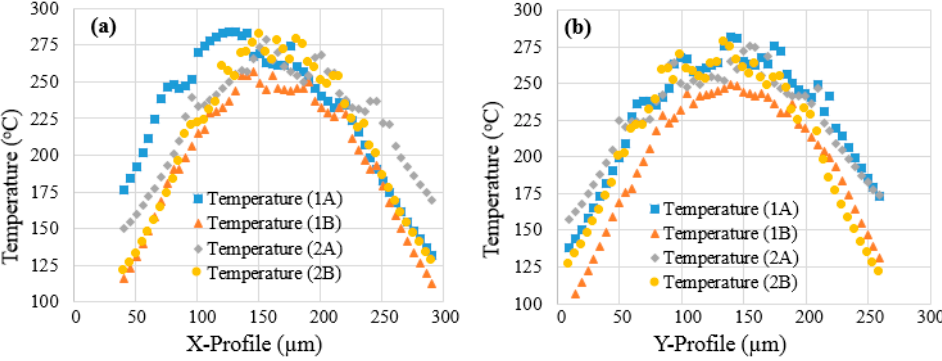
Figure 5. Experimental values of temperature distribution at 270 °C on ( a ) x -axis ( b ) y -axis of micro-